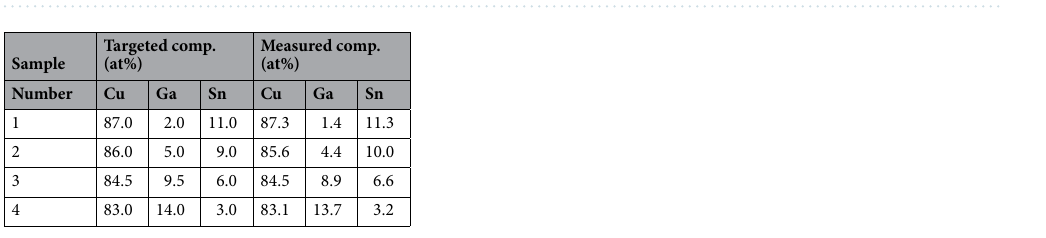
Table 1. Targeted compositions of the four sample rods compared with results of EDX measurements in the as-cast microstructure.